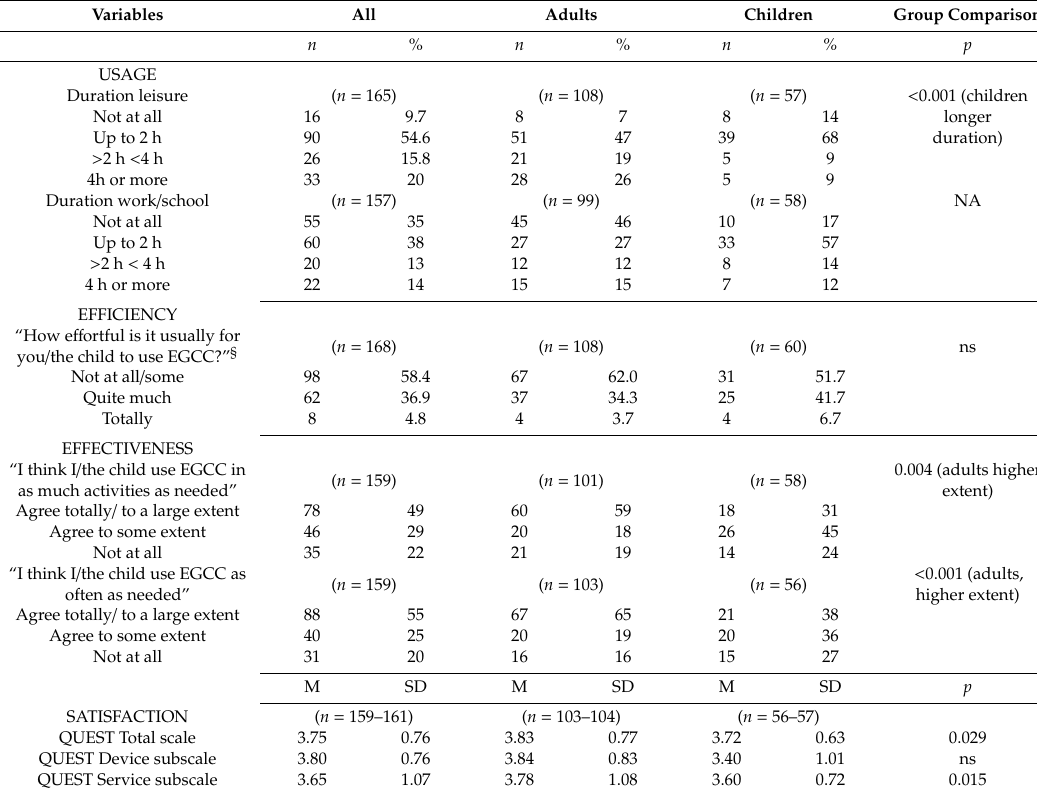
Table 2. Responses on some of the use and usability questions in the